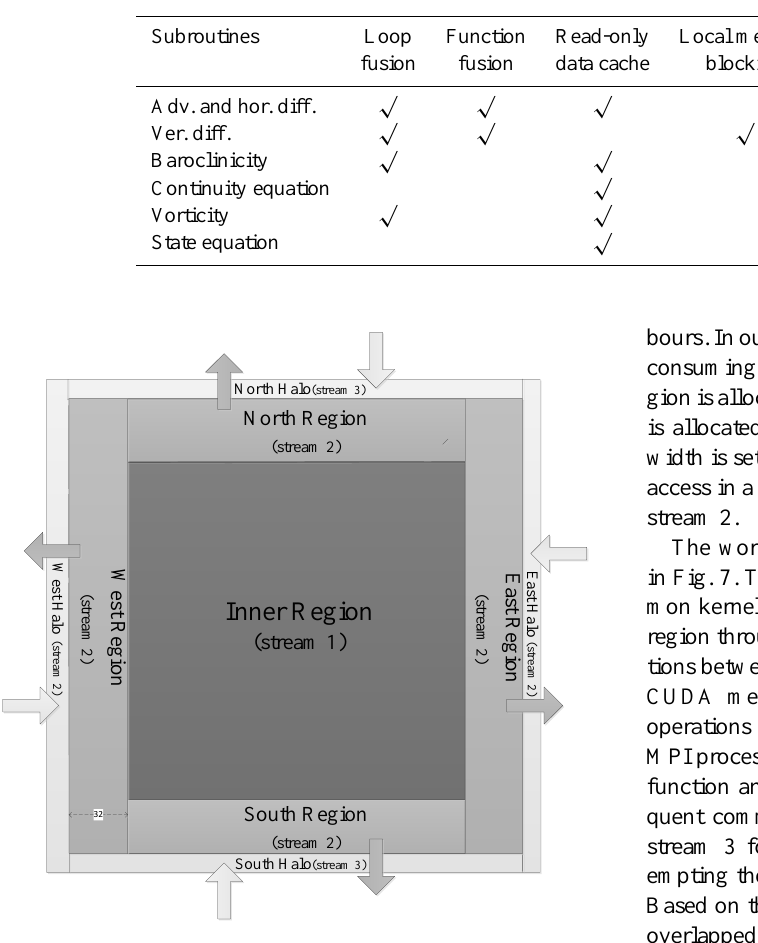
(2010) and Yang et al. (2013) proposed fine-grained